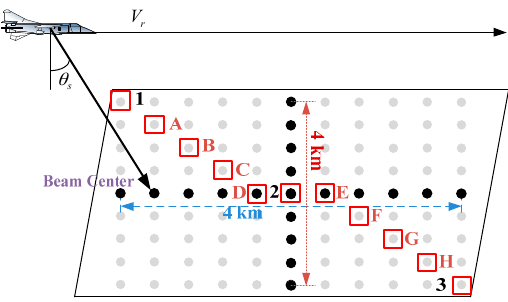
Figure 4. Flight geometry and dot-matrix targets.